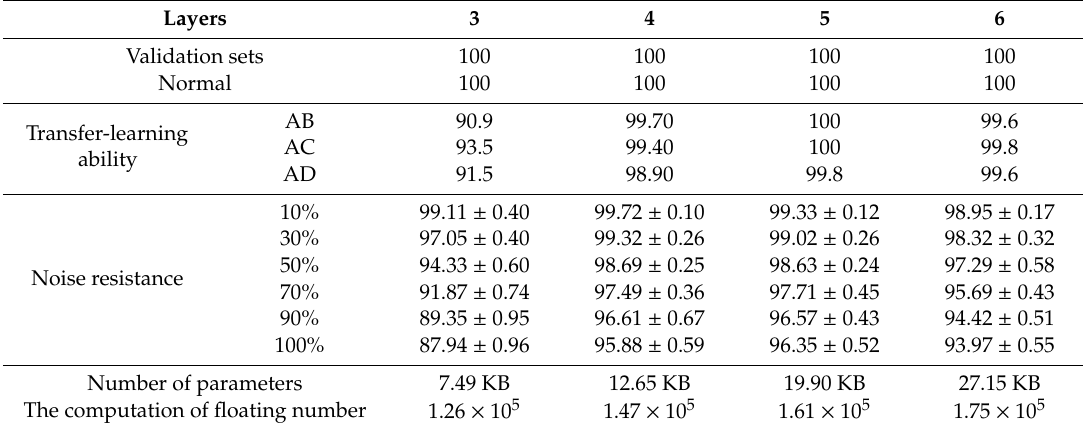
Table 10. Comparison of the noise resistance and transferability of the network structures with various depths.